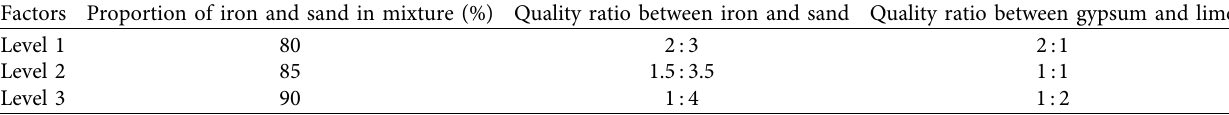
Table 6: Value of control index.